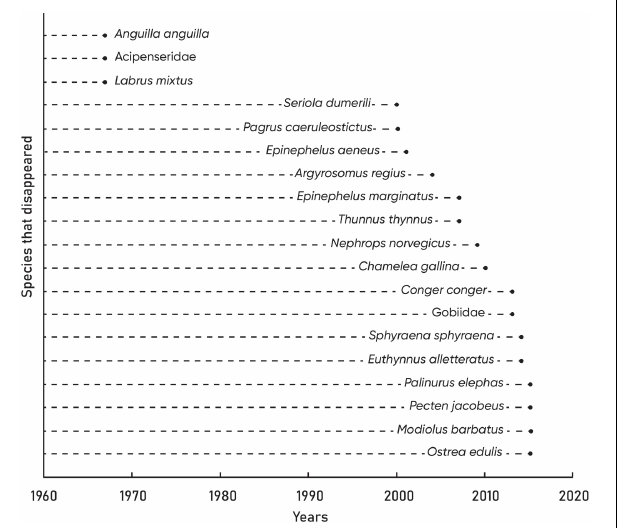
FIGURE 3 | A timeline of marine extirpations from the Sea of